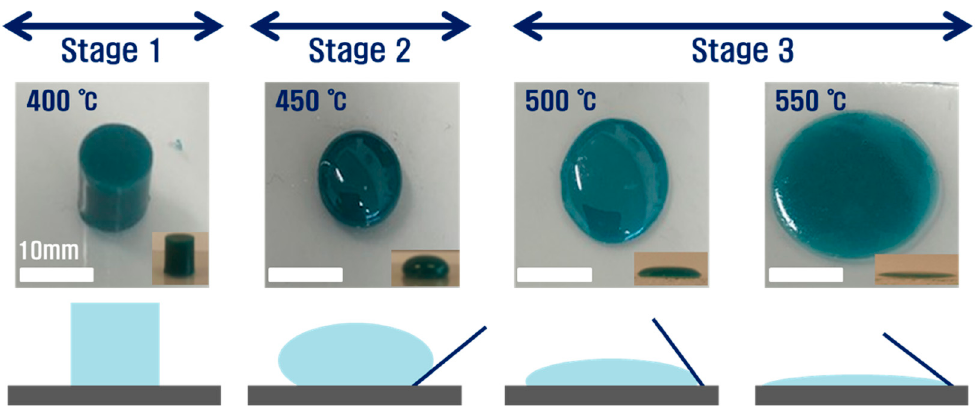
Figure 6. The shape change of pellets (1 wt% CuO and 2 wt% Na 2 CO 3 codoped PSAB glass system) as a function of sintering temperature; inset shows the side view of pellets.